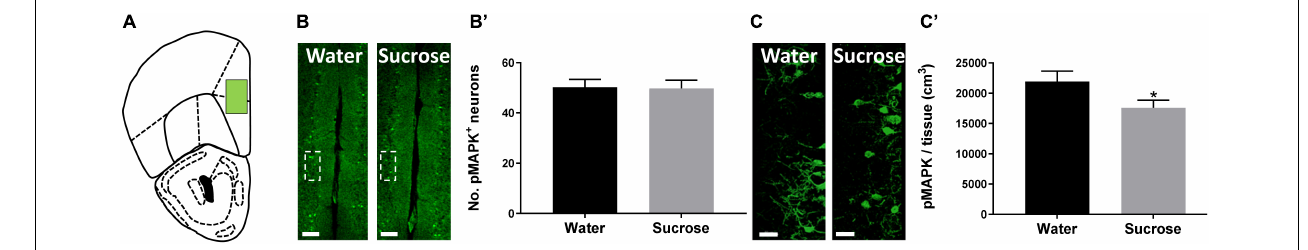
FIGURE 2 | Neuroplastic changes after sucrose consumption. (A) Schematic drawing showing the location of the acquired micrographs (prefrontal cortex). (B) Low-magnification representative image of the prefrontal cortex showing the distribution of the pMAPK positive cells. Scale: 250 µ m. (B’) Quantification of pMAPK positive neurons showed no difference after sucrose consumption. (C) High-resolution representative image of pMAPK somatodendritic staining reconstruction. Scale: 50 µ m. (C’) The volume of pMAPK neurons/staining was reduced after sucrose consumption. Data are expressed as mean ± SEM ( t -test). * p < 0.05, compared with vehicle ( n = 8 per treatment